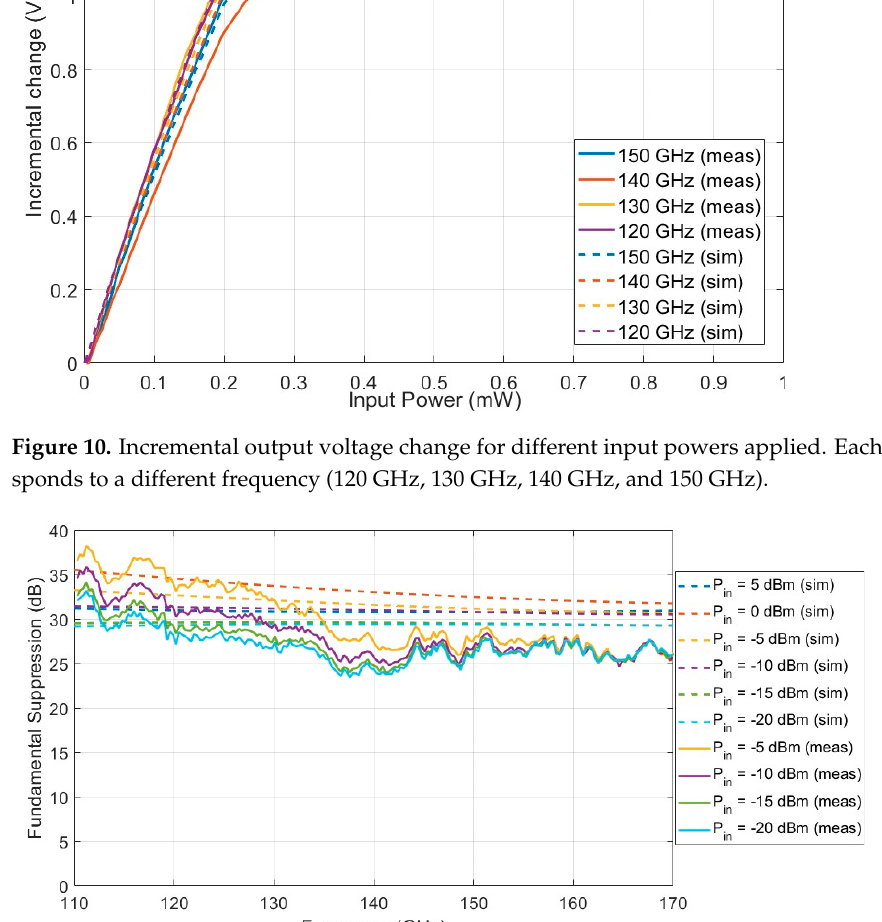
Figure 11. Simulated and measured suppression of the fundamental at the output of the PD. Six different values for the input power were used, from − 20 dBm to 5 dBm during the simulation, and four different values for the input power were used, from − 20 dBm to − 5 dBm during the meas- urement.